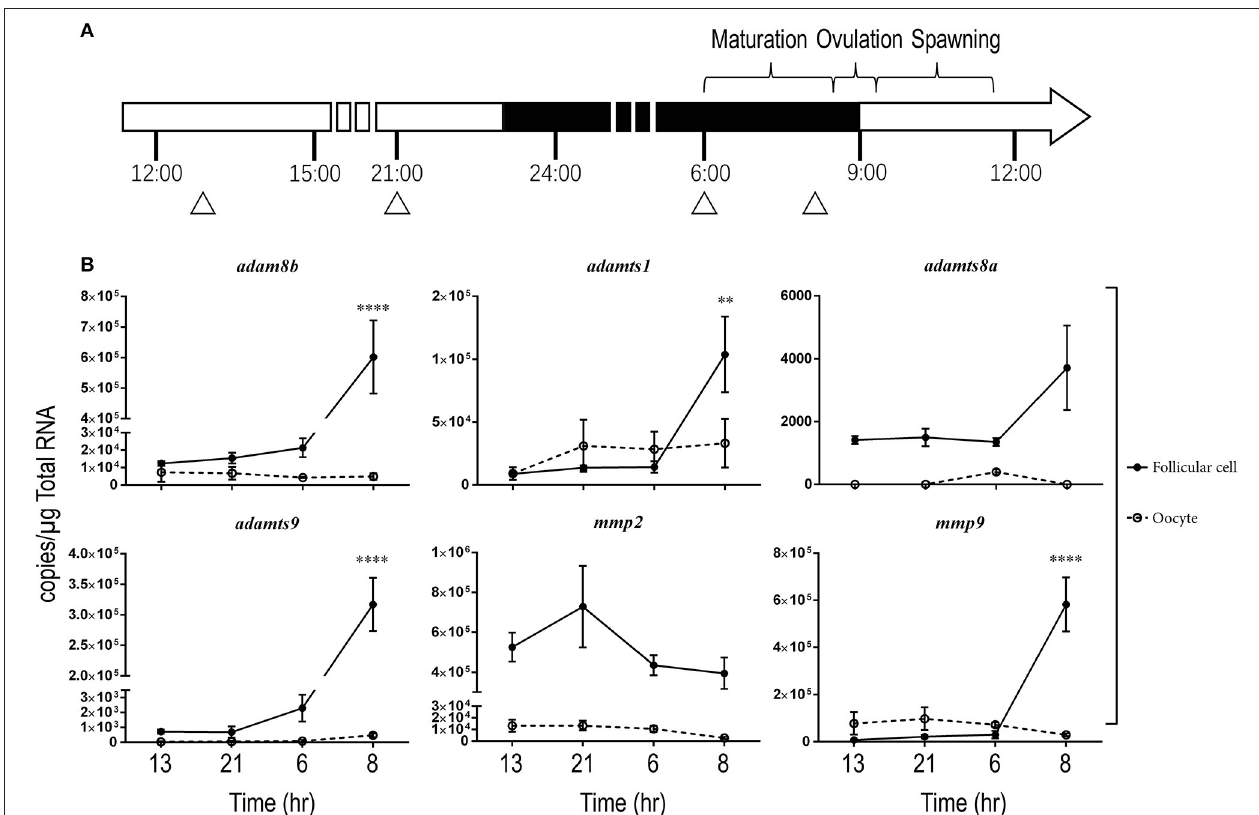
FIGURE 2 | Expressions of adam8b , adamts1 , adamts9 , and mmp9 transcripts significantly increased in stage IV preovulatory follicular cells during a daily spawning cycle in wildtype ( wt ) fish in vivo . Transcripts of representative metalloproteinases were determined in stage IV follicular cells (solid line with filled circles) or denuded oocytes (dash line with open circles) separately during a daily spawning cycle in wt fish. (A) A schematic drawing showing the daily ovulatory cycle of zebrafish. Day and night cycles are indicated by open or black bars, respectively. Lights were switched on at 09:00 and off at 23:00. Approximate time for daily oocyte maturation, ovulation and spawning in zebrafish are indicated on top of the bar. Samples were collected from four representative time points, indicated by triangles: 13:00 (after spawning), 21:00 (2h before lights off), 06:00 (prior to oocyte maturation), and 08:00 (after oocyte maturation but prior to ovulation). (B) Expression of representative metalloproteinase transcripts were determined by qPCR. Asterisks indicate a significant increase of transcripts compared to the previous sampling time point in follicular cells (solid line with black circles). No significant change was observed in the denuded oocytes (dash line with open circles). ** p < 0.01, **** p < 0.0001. N =